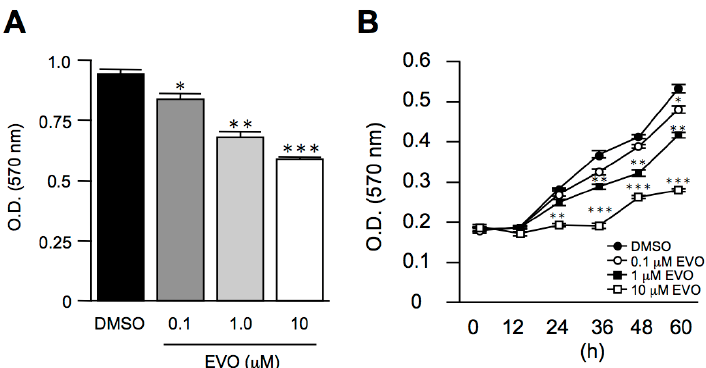
Figure 1. Evodiamine inhibited Mus musculus hepatoma, Hepa1-6 cell proliferation. Mus musculus hepatoma cell line and Hepa1-6 cells were treated with different doses of evodiamine for 24 h ( A ) or treated with 10 μ M evodiamine and harvested at the indicated periods ( B ). The cells were then incubated with 0.2 mg/mL MTT in culture medium for three hours. The absorbance was measured at a wavelength of 570 nm. The data are expressed as means ± S.E.M. and obtained from two independent experiments, with three replicates for each experiment. * p < 0.05, ** p < 0.01, and *** p < 0.001 compared